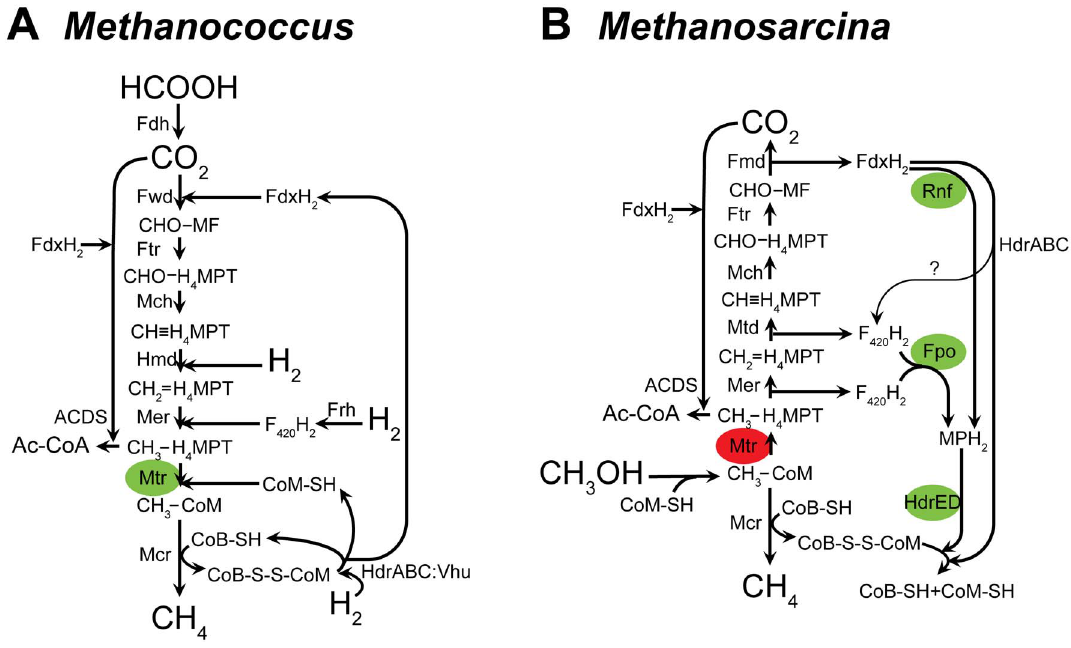
Figure 2. Comparison of methanogenesis pathways. A , Hydrogenotrophic methanogenesis in Methanococcus maripaludis. B , Methylotrophic methanogenesis in Methanosarcina acetivorans . Green ovals: energy-conserving reactions. Red ovals: energy-consuming reaction. Please see text for abbreviations.